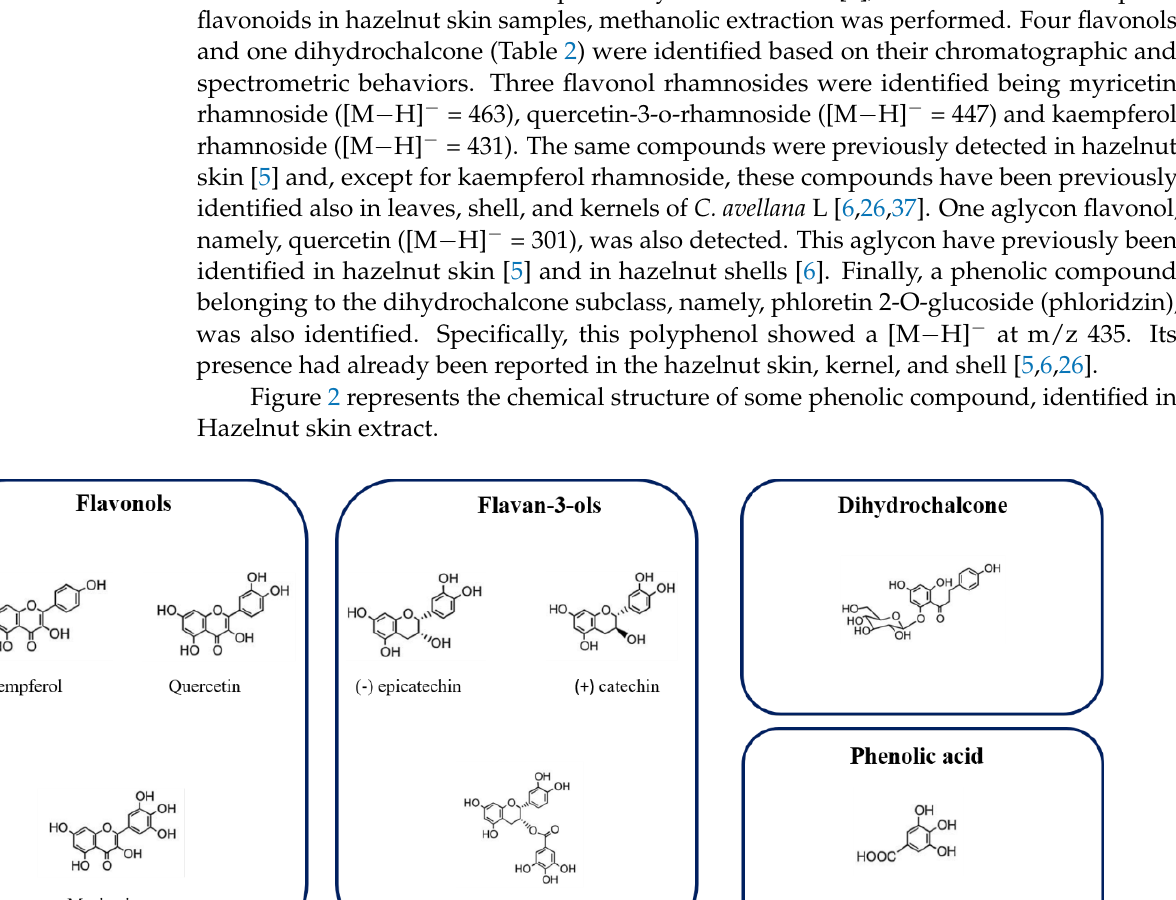
Figure 2. Chemical structure of some phenolic compounds identified in Hazelnut skin extract. Table 1. Peaks identification of hazelnut skin aqueous extract through HPLC/ESI-MS.